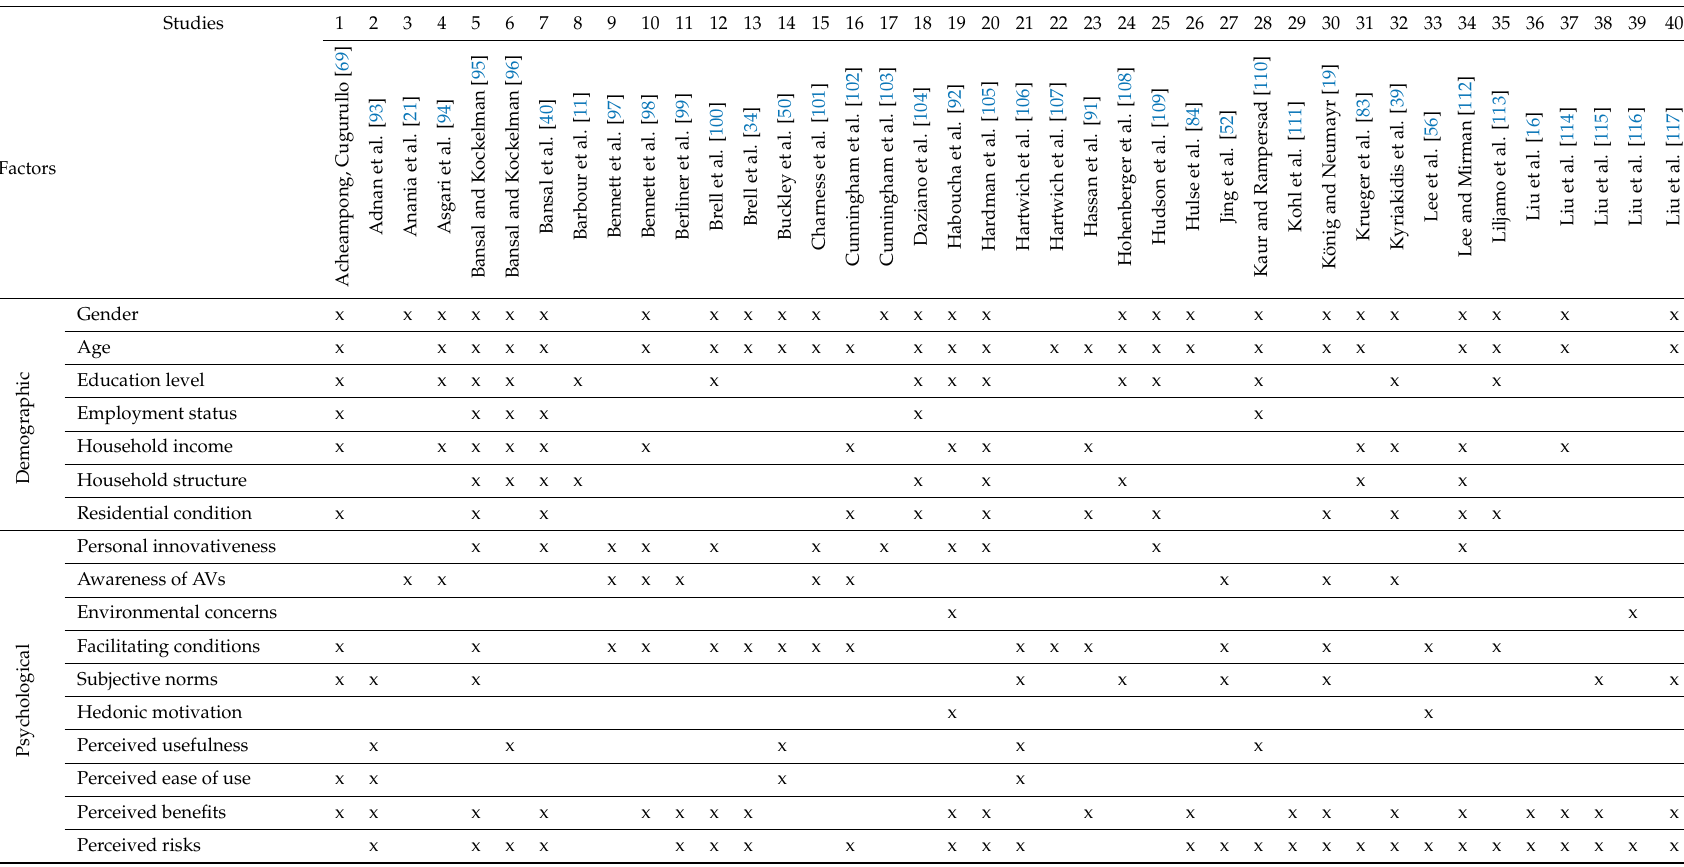
Table 3. Individual factors a ff ecting public acceptance and adoption intention of AVs (x = the factor is covered in the mentioned study) (Source: Authors).